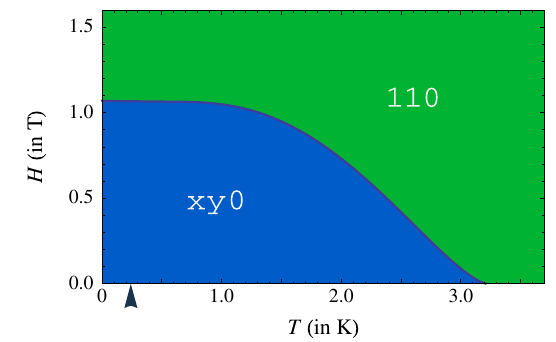
FIG. 5. Field versus temperature phase diagram obtained from a mean-field analysis of the Hamiltonian of Eq. (1), for a field H parallel to the [110] direction and with the exchange constant values obtained with our fits, Eq. (3). The system displays a net magnetic moment throughout the ð H; T Þ plane. The blue region denotes a region where the total magnetization lies in the xy plane, and the green region is the paramagnetic phase; the two zones are separated by a continuous transition. In zero field, this ¼ 3 : 2 K . At zero temperature, the transition takes place at T MF c ¼ 1 : 1 T . The dark blue amplitude of the transition field is H MF c arrow shows the experimentally reported transition temperature of 240 mK: The actual transition occurs at a much lower . temperature than that predicted by mean-field theory T MF c